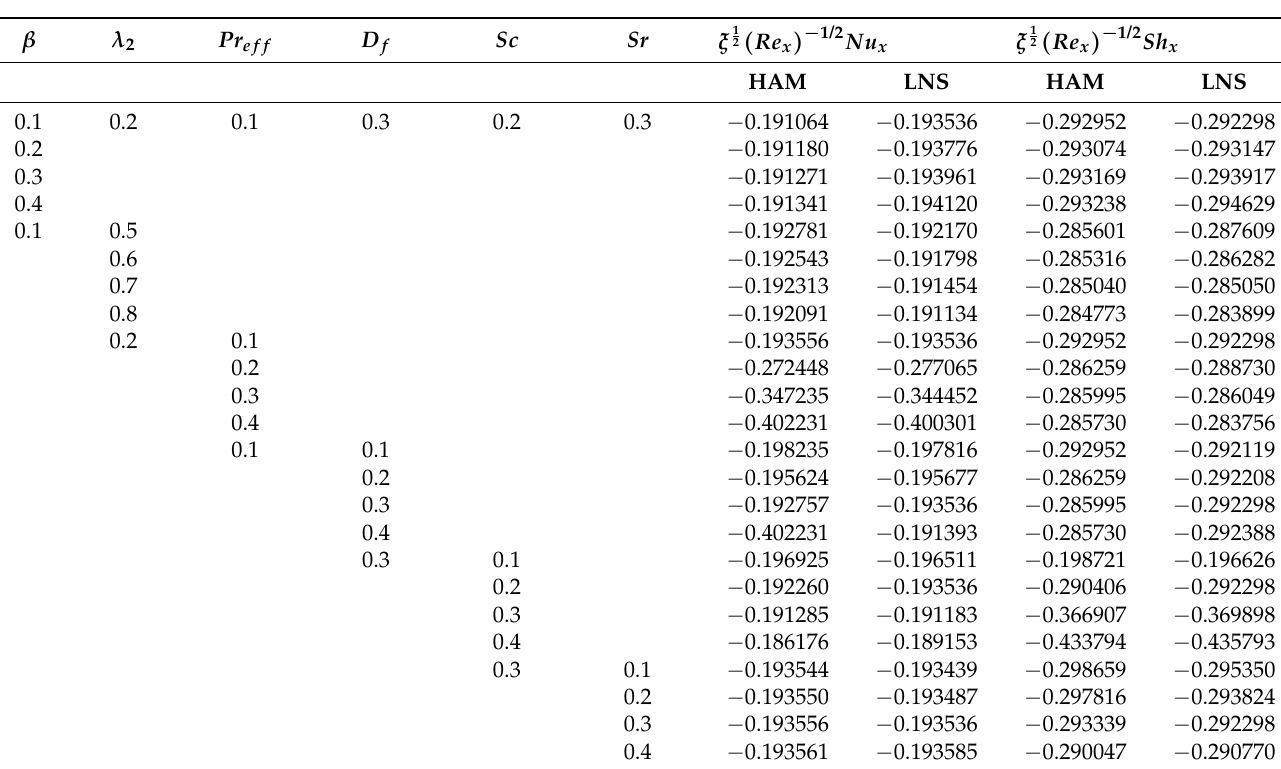
Table 6. The impact of emerging parameters on the Nusselt number Nu x and Sherwood number Sh x with R d =